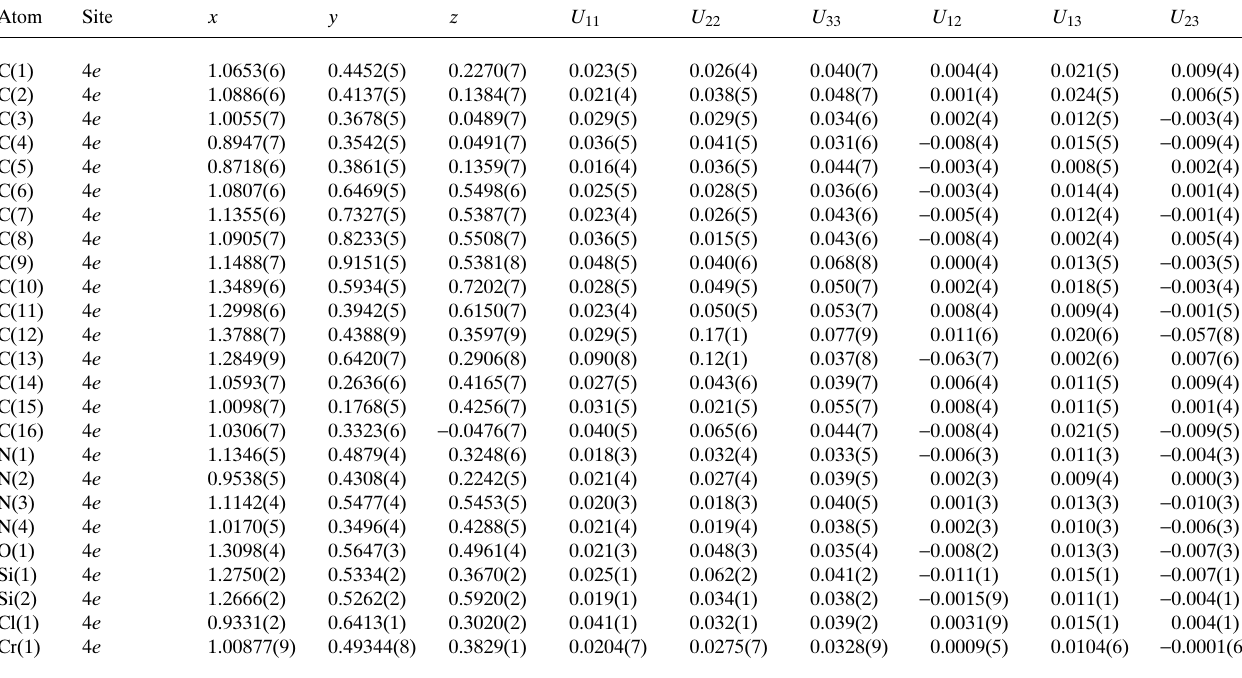
Table 3. Atomic coordinates and displacement parameters (in Å 2 ) .